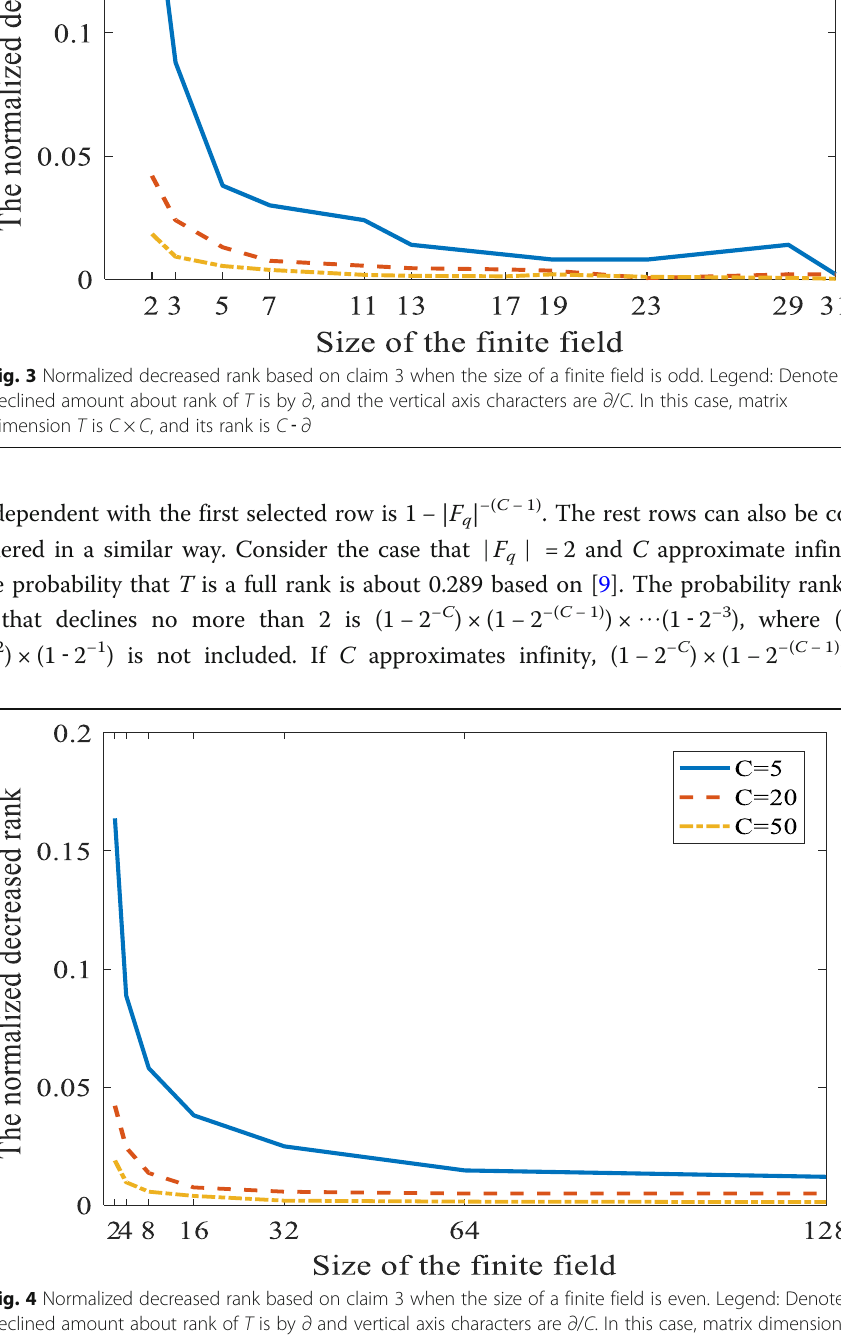
Fig. 4 Normalized decreased rank based on claim 3 when the size of a finite field is even. Legend: Denote declined amount about rank of T is by ∂ and vertical axis characters are ∂ / C . In this case, matrix dimension T is C × C , and its rank is C ‐